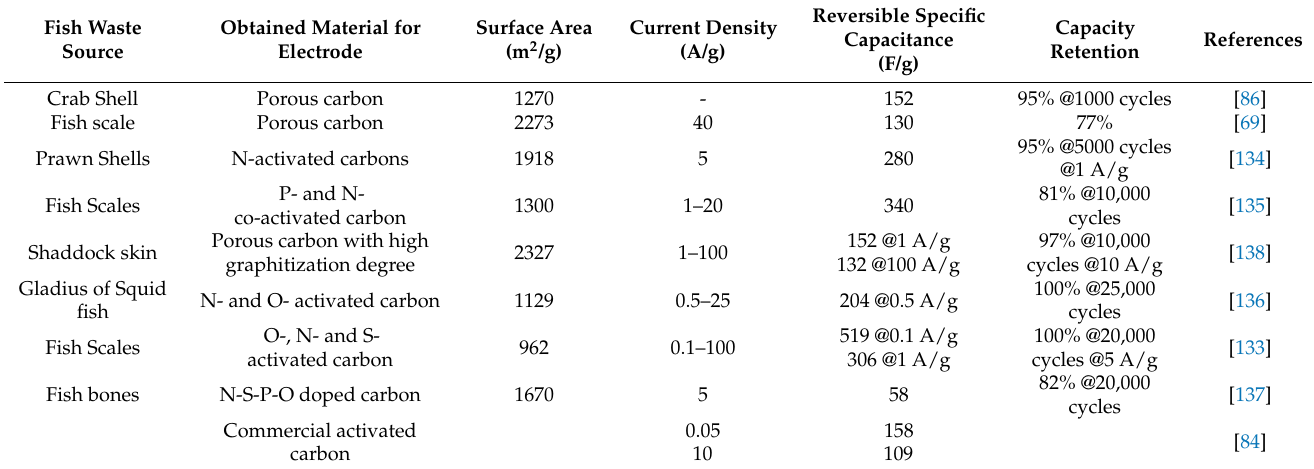
Table 4. Performance of porous carbon-based electrodes from fish waste for